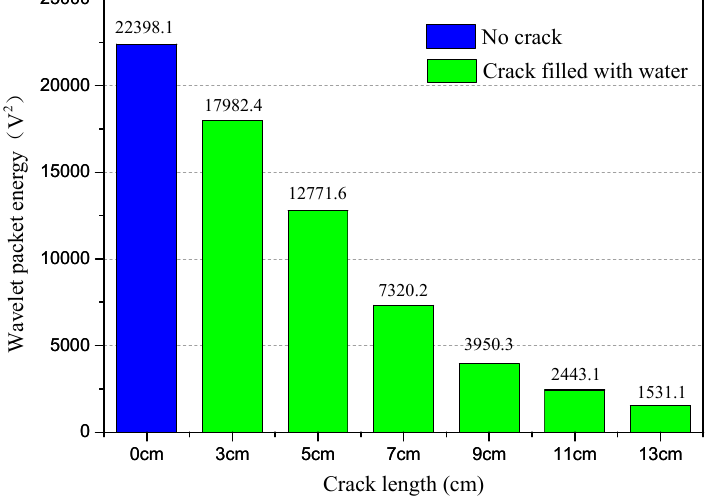
Figure 13. Wavelet-packet-based energy indices (WPEIs) of collected signals for test cases with no crack and empty crack.